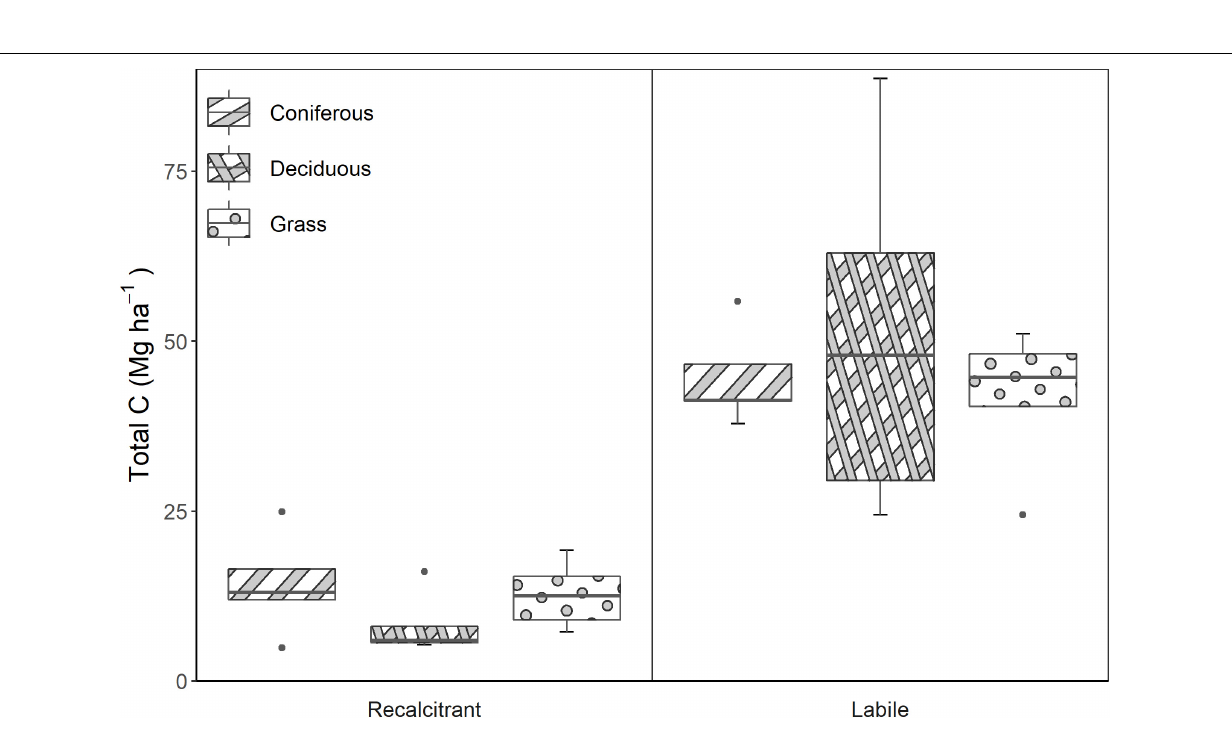
Frontiers in Forests and Global Change |